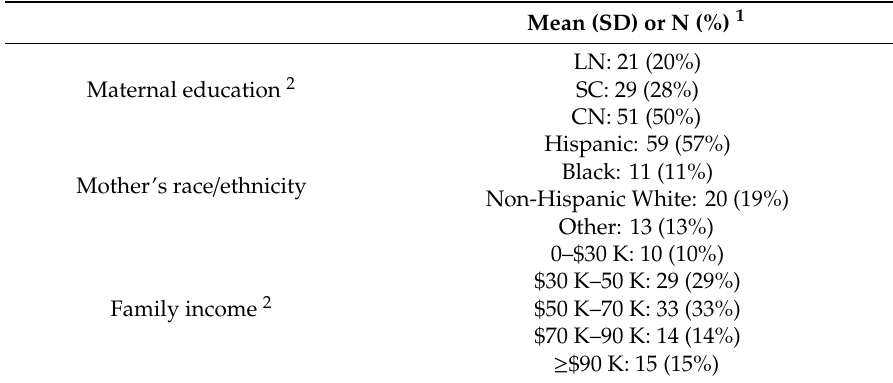
Table 2. Familial